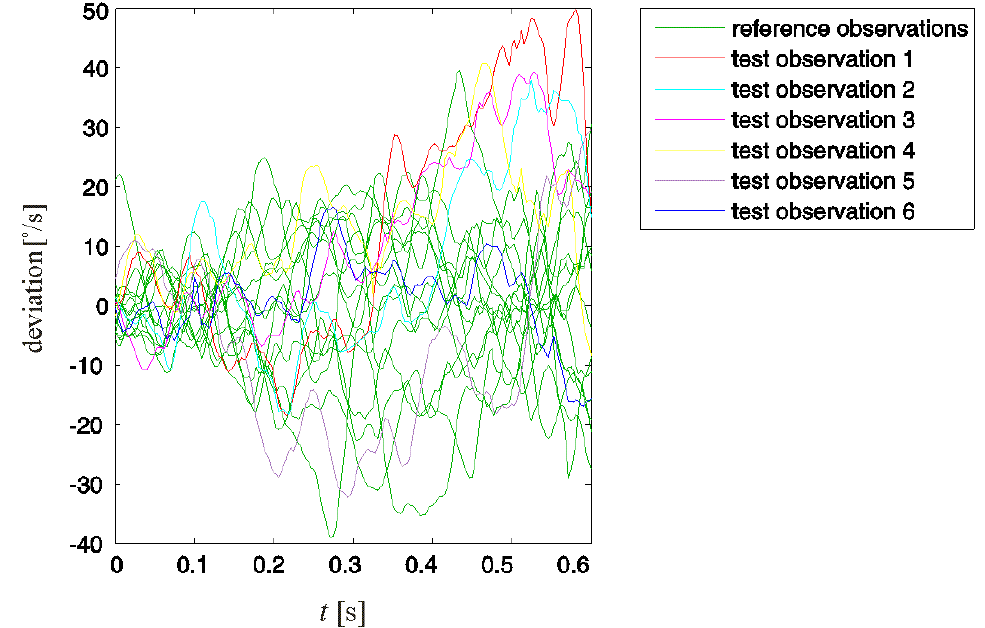
Figure 5. Acceptable and test deviations from the desired swing motion.